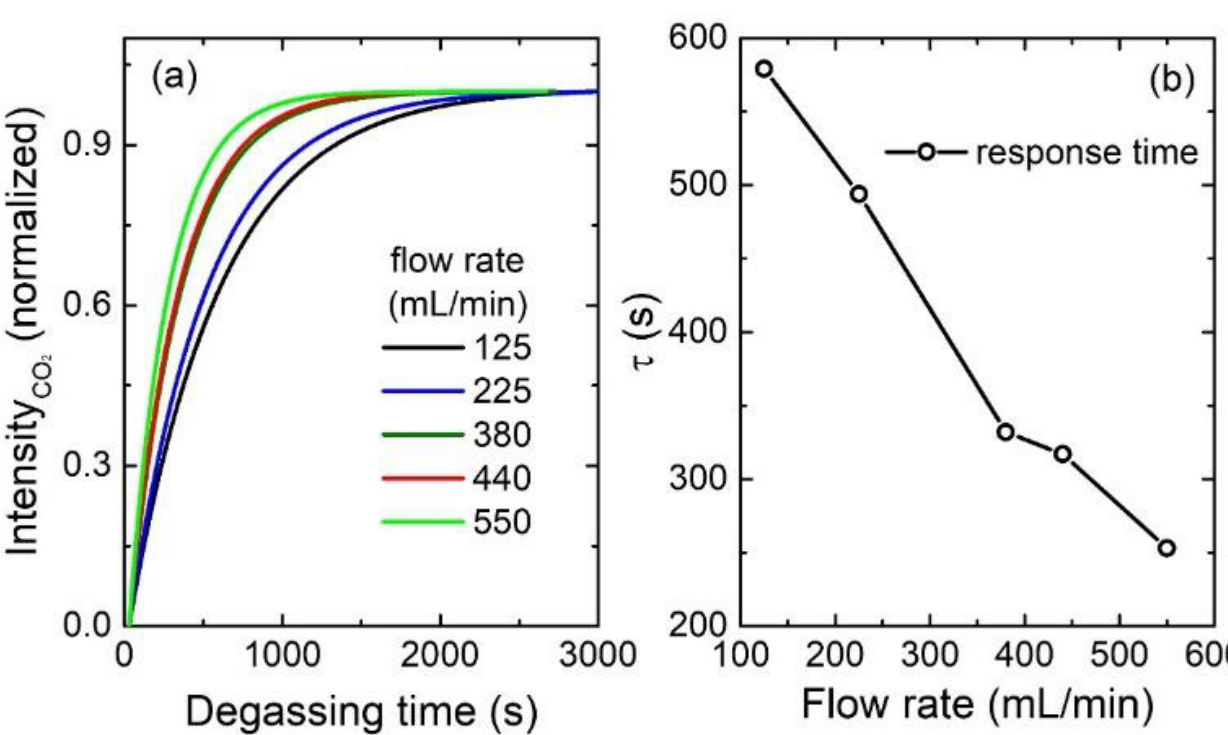
Figure 6. The fitted curves of CO 2 signal intensity with degassing time at different flow rates ( a ); the response time variation with the flow rate ( b ).